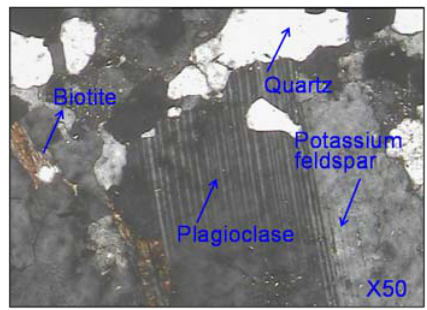
Figure 7. Mineral phases of granite.